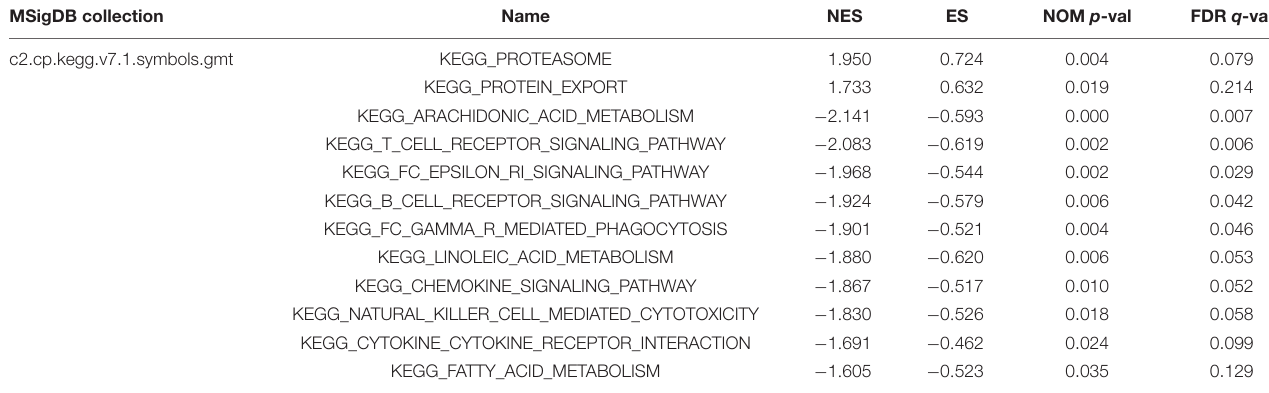
TABLE 4 | Gene sets enriched in the high-risk and low-risk